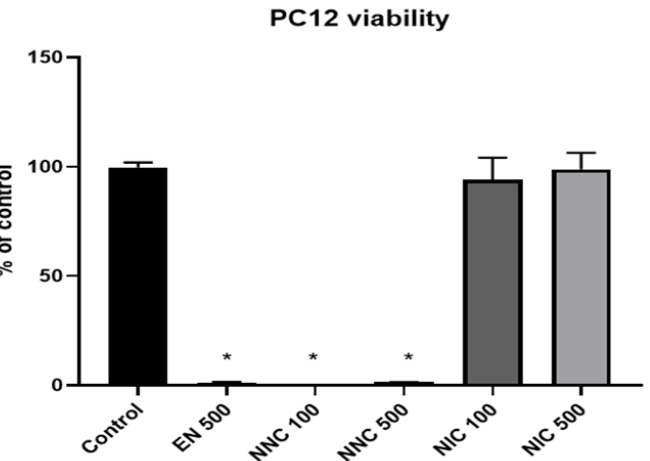
Figure 8. Viability of PC12 cells at seven days in culture. EN 100 = empty nanocapsules (group 2); EN 500 = empty nanocapsules (group 3); NNC 100 = nicotine containing nanocapsules 100 µ M (group 4); NNC 500 = nicotine containing nanocapsules 500 µ M (group 5); NIC 100 = 100 µ M of bulk nicotine (group 6); NIC 500 = 500 µ M of bulk nicotine (group 7); (*: p < 0.05 samples vs. control); n = 3.